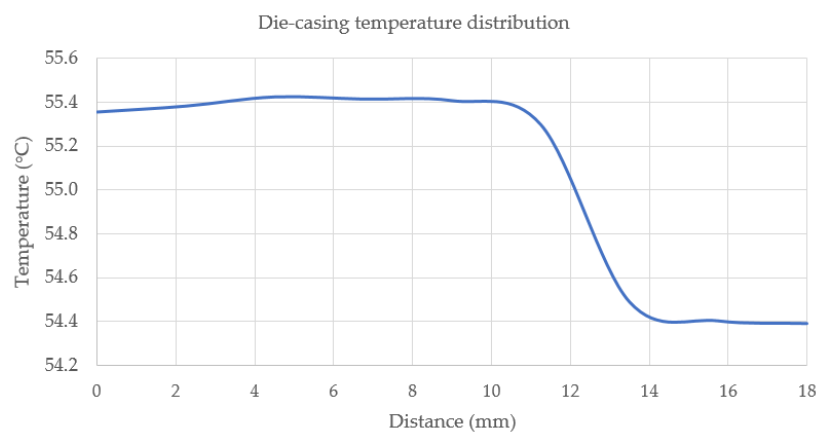
Figure 7. Results of the simulations carried out the temperature on the path between the die of the semiconductor diode and the point of the housing, the temperature of which is closest to the die temperature. The result obtained for Pj = 5.48 W.